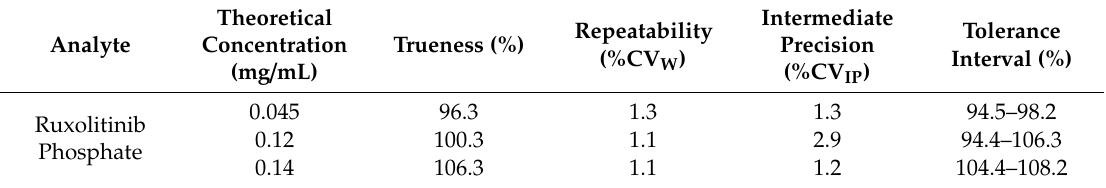
Table 1. Trueness (%), repeatability (%CV W ), intermediate precision (%CV IP ), and tolerance interval (%) of the developed method. CV, coe ffi cient of